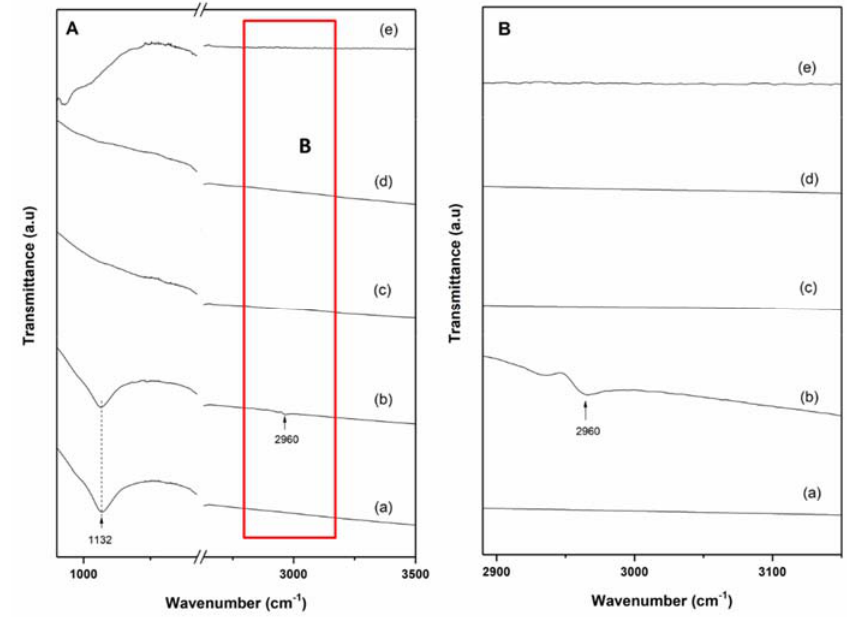
Figure 7. FT-IR spectrum of the non-confined and confined Li-RHC d + 7.5(3TiCl 3 · AlCl 3 ) materials: Figure 7. FT ‐ IR spectrum of the non ‐ confined and confined Li ‐ RHC d +7.5(3TiCl 3 ∙ AlCl 3 ) materials: A ( A ) (a) Li-RHC d + 7.5(3TiCl 3 · AlCl 3 ) after milling; (b) Li-RHC d + 7.5(3TiCl 3 · AlCl 3 ) with TPX TM after (a) Li ‐ RHC d +7.5(3TiCl 3 ∙ AlCl 3 ) after milling; (b) Li ‐ RHC d +7.5(3TiCl 3 ∙ AlCl 3 ) with TPX TM after milling; milling; (c) Li-RHC d + 7.5(3TiCl 3 · AlCl 3 ) after 10 th cycle; (d) Li-RHC d + 7.5(3TiCl 3 · AlCl 3 ) with TPX TM (c) Li ‐ RHC d +7.5(3TiCl 3 ∙ AlCl 3 ) after 10 th cycle; (d) Li ‐ RHC d +7.5(3TiCl 3 ∙ AlCl 3 ) with TPX TM after 10 th after 10 th cycle; and (e) pure 3TiCl 3 · AlCl 3 . ( B ) Zoom of ( A ) between 2890 to 3150 cycle; and (e) pure 3TiCl 3 ∙ AlCl 3 . B Zoom of A between 2890 to 3150 ppm.